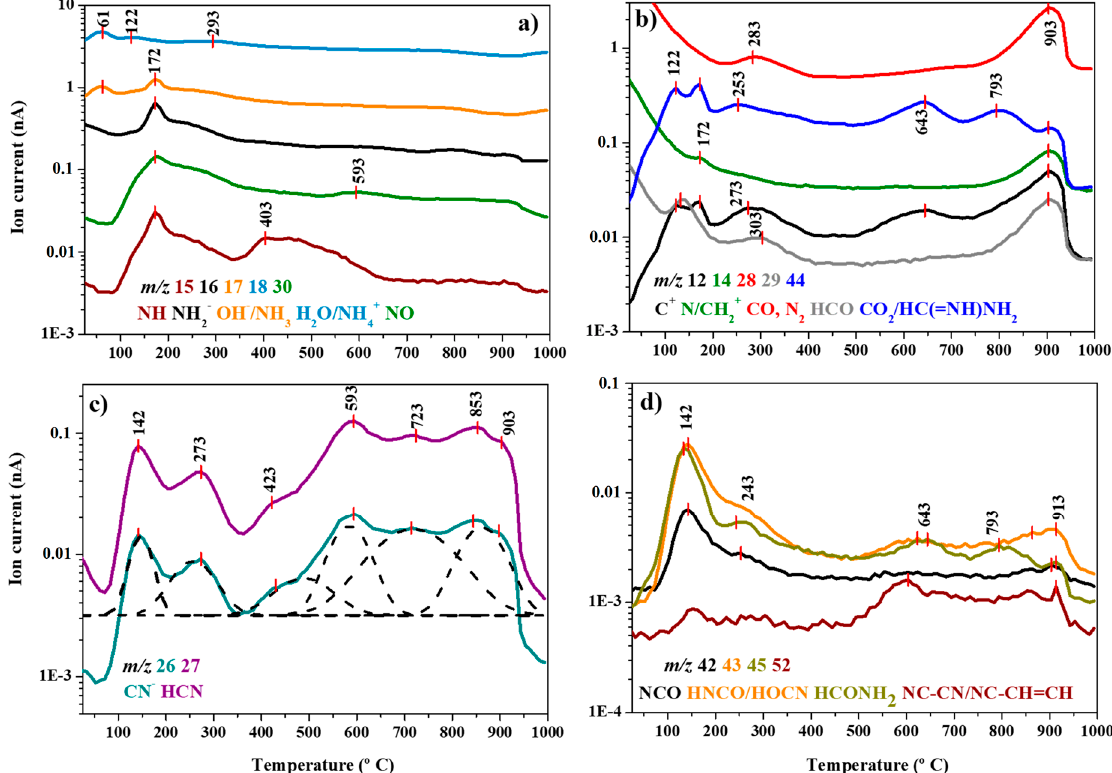
Figure 3. Ion intensity curves for HCN-derived thermal polymer. Deamination and decarboxylation mechanisms during pyrolysis stages dominate over dehydration. ( a ) Major signals associated with the releasing of amines and water; ( b ) signals associated with carbon and nitrogen species released though scission and/or depolymerization mechanisms; ( c ) cyanide and HCN curves; and ( d ) signals associated with the cleavage of the polymer chain through the release of larger species.